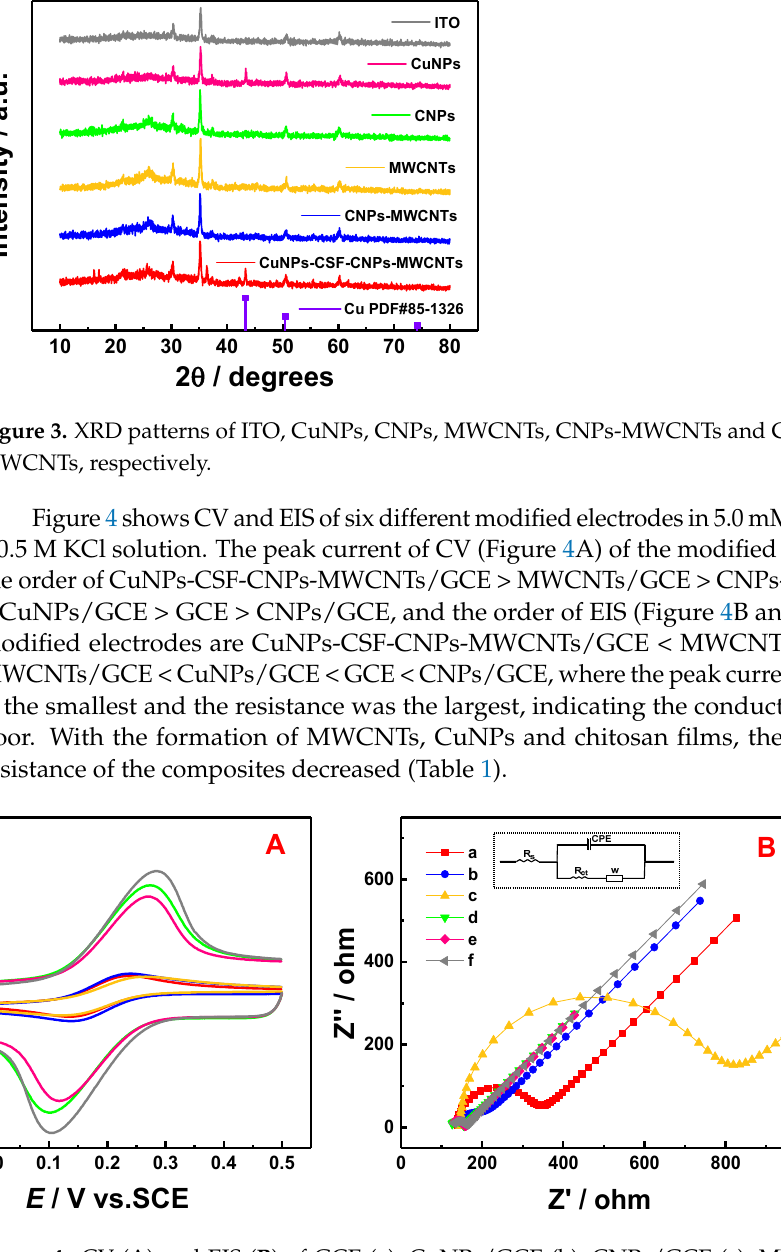
Figure 4. CV ( A ) and EIS ( B ) of GCE (a), CuNPs/GCE (b), CNPs/GCE (c), MWCNTs/GCE (d), CNPs-MWCNTs/GCE (e) and CuNPs-CSF-CNPs-MWCNTs/GCE (f) in 5.0 mM [Fe(CN) 6 ] 3 − /4 − + 0.5 M KCl solution, respectively. Scan rate of 100 mV/s. EIS parameters: 100 kHz~5 mHz, 5 mV rms, 0.19 V vs. SCE. Table 1. The values of EIS equivalent circuit elements for each electrode.